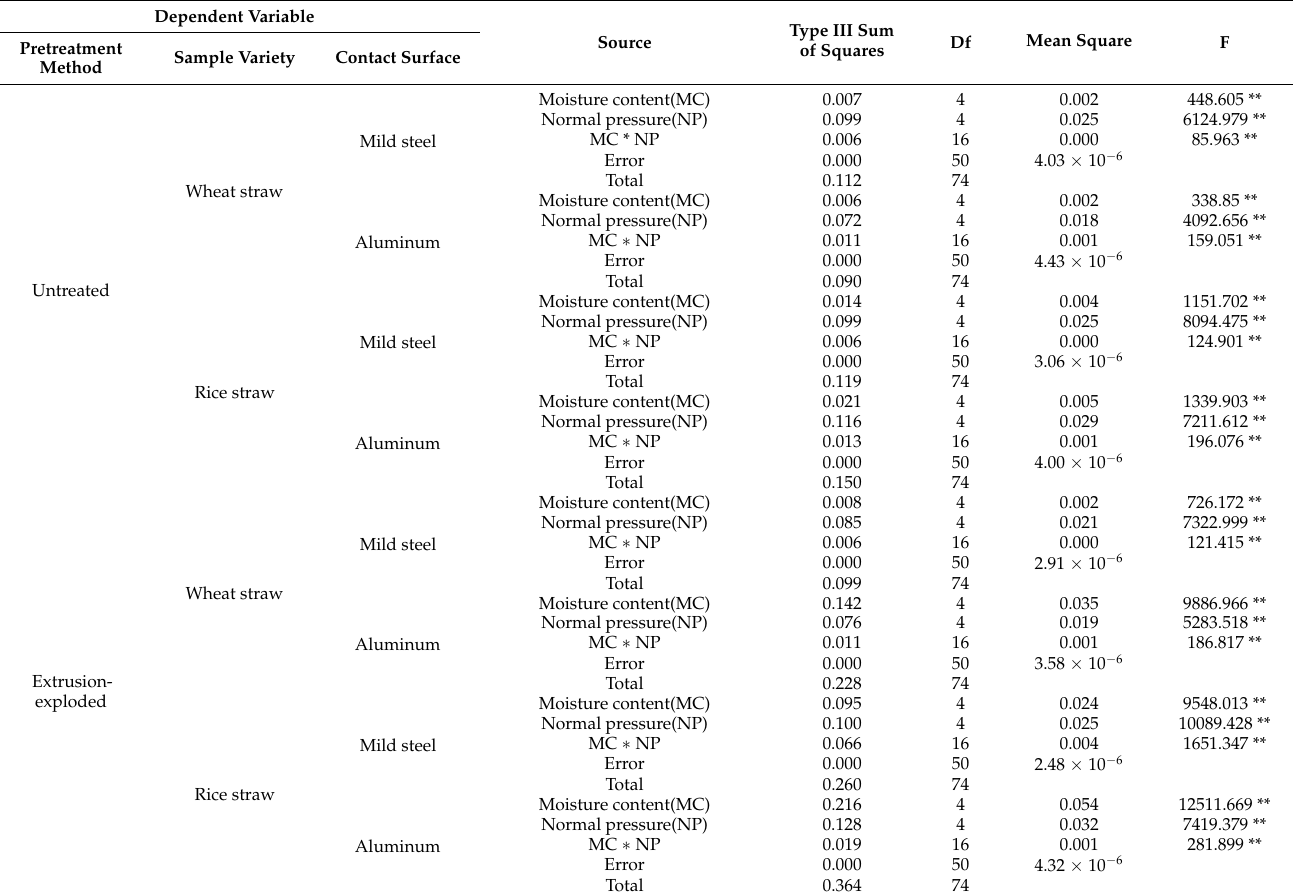
Table 4. The ANOVA results for the coefficient of sliding friction versus the moisture content and normal pressure.